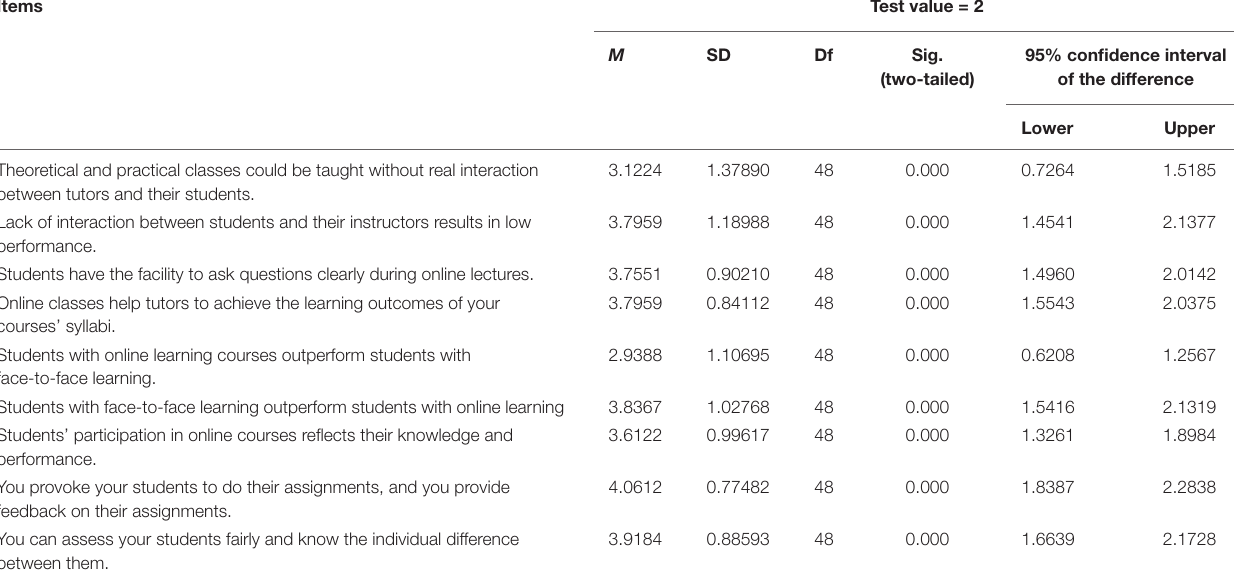
TABLE 3 | Faculty’s perception of the effectiveness of online teaching. Items